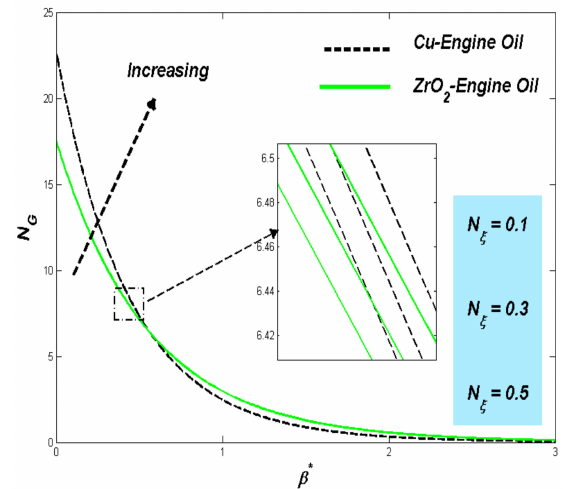
Figure 18. Entropy profile change with N ξ .